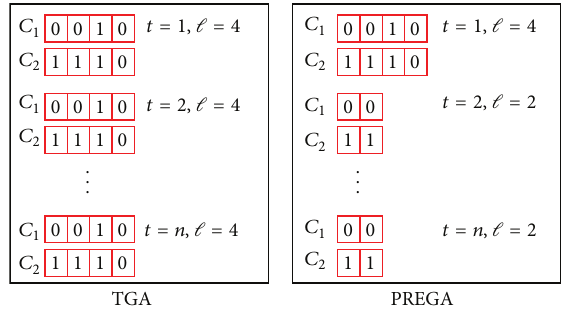
Figure 1: A simple example illustrating the difference between GA and PREGA. Note that genes common to chromosomes 𝐶 1 and 𝐶 2 are saved away by PREGA at generation 𝑡 = 1 but not by